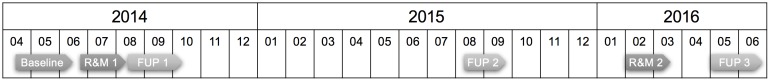
Time line of the study.R&M = Renovation and modernization; FUP = follow-up.